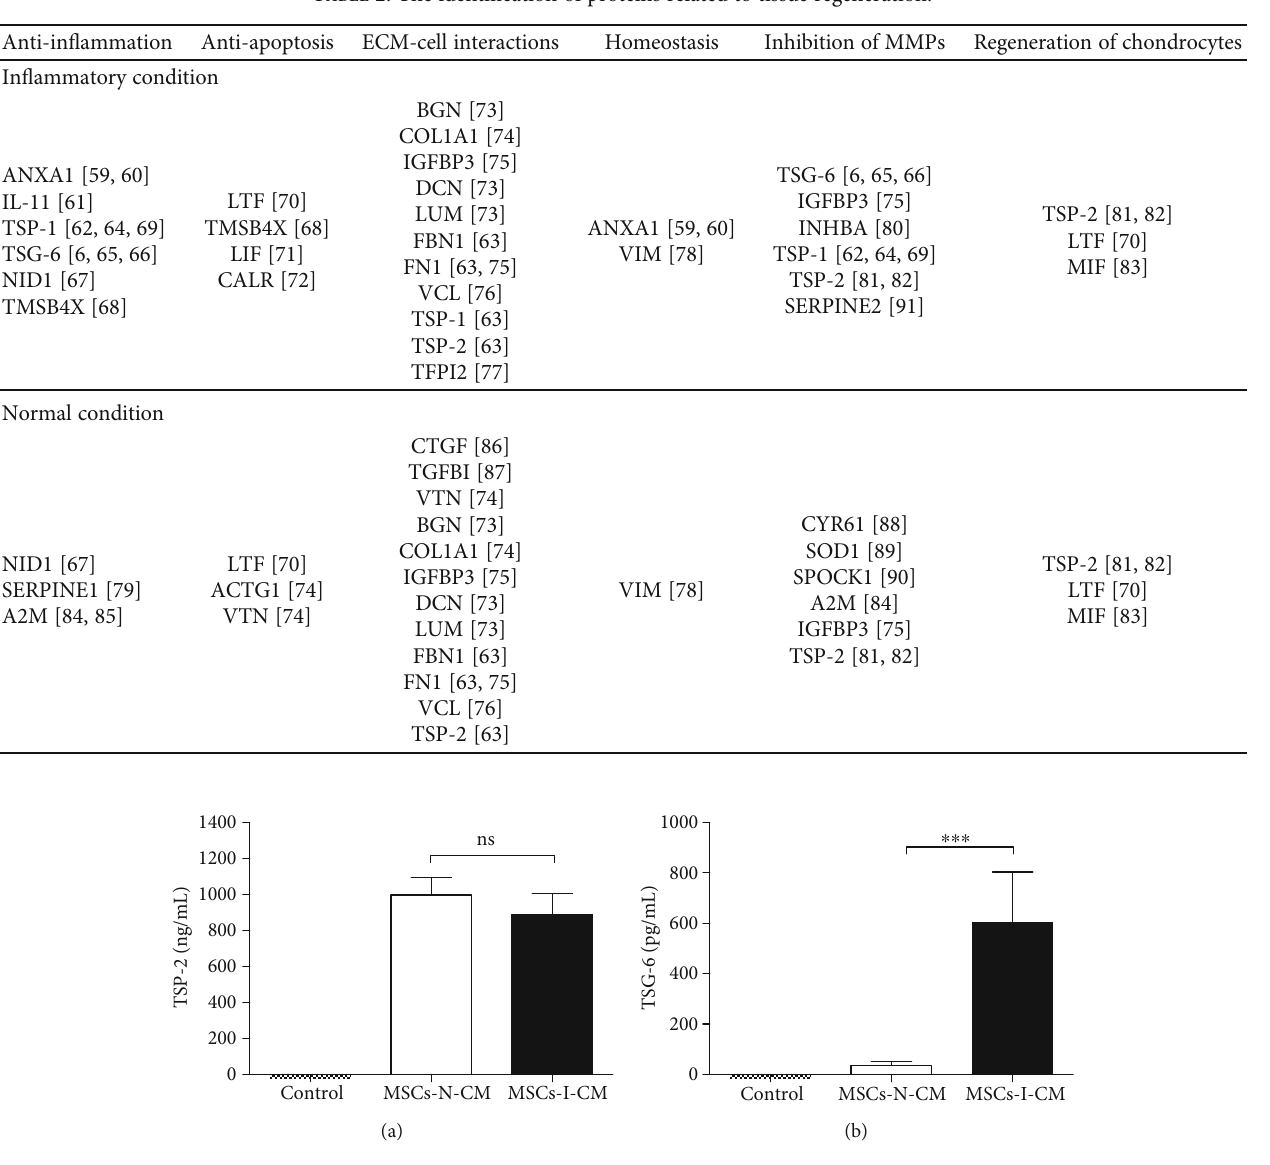
Figure 6: Validation experiments of key protein expression under various knee OA conditions using ELISA: (a) human TSP-2; (b) human TSG-6. ∗∗∗ P < 0 : 0001 . ns: not signi fi cant ( n = 9 , three donors for each MSC type); N-CM: normal condition-conditioned medium; I-CM: in fl ammatory condition-conditioned